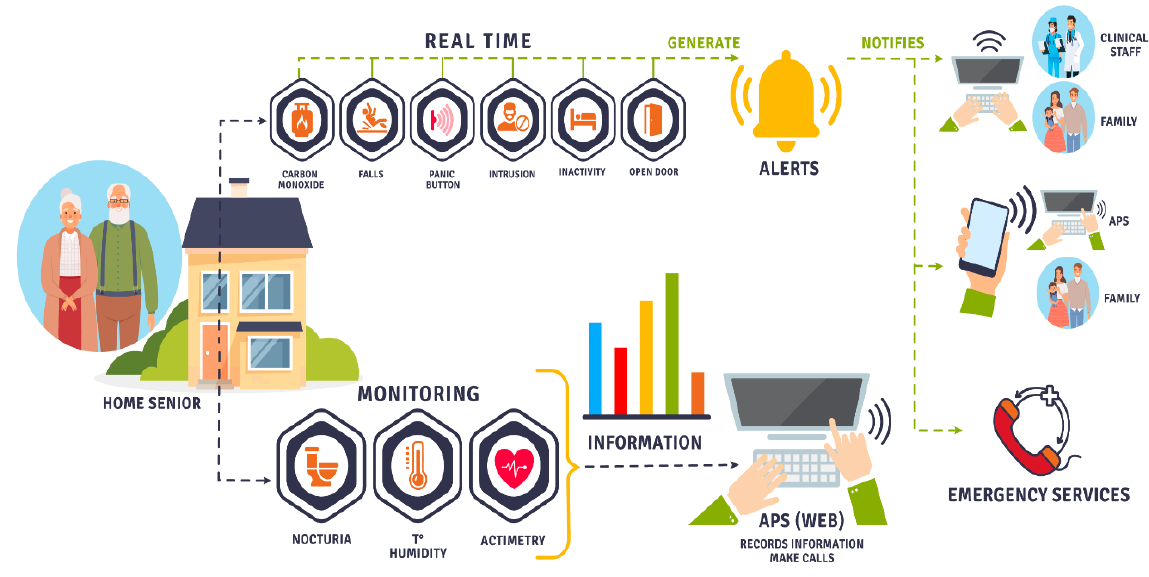
Figure 1. Quida: Integrated monitoring model.